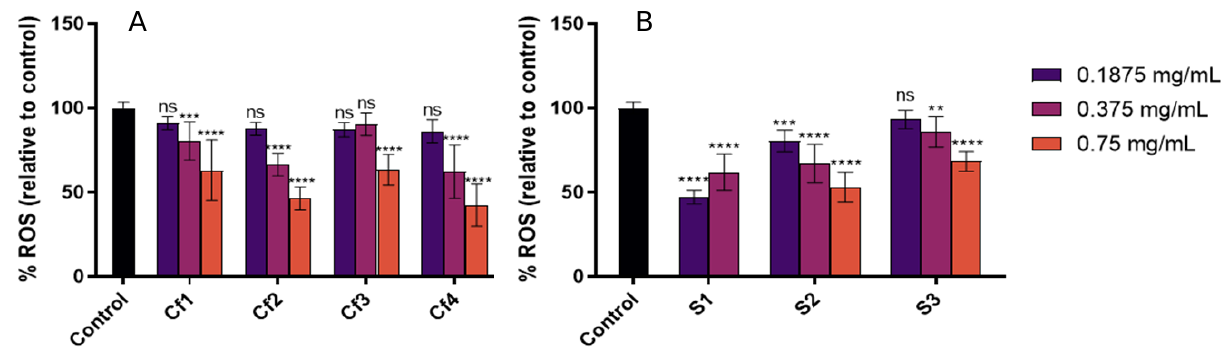
Figure 1. Cellular antioxidant capacity, expressed as % of ROS inhibition relative to the control, of each extract. ( A ) Codfish frame extracts; ( B ) Sardine wastes extracts. The results are expressed as mean ROS percentage relative to the control ± SD. The symbol * indicates significance relative to the control ** p - value ≤ 0.01, *** p - value ≤ 0.001, **** p - value ≤ 0.0001); ns— not significant.